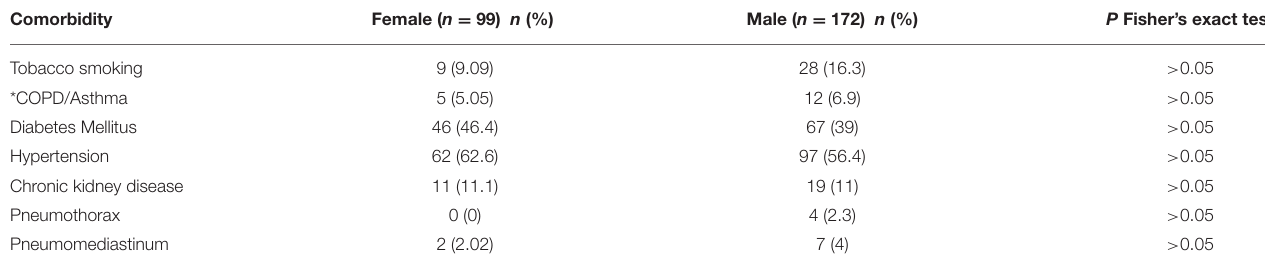
TABLE 2 | Comorbidities measured in the general population with COVID-19 diagnosis ( n = 271). Comorbidity Female ( n = 99) n